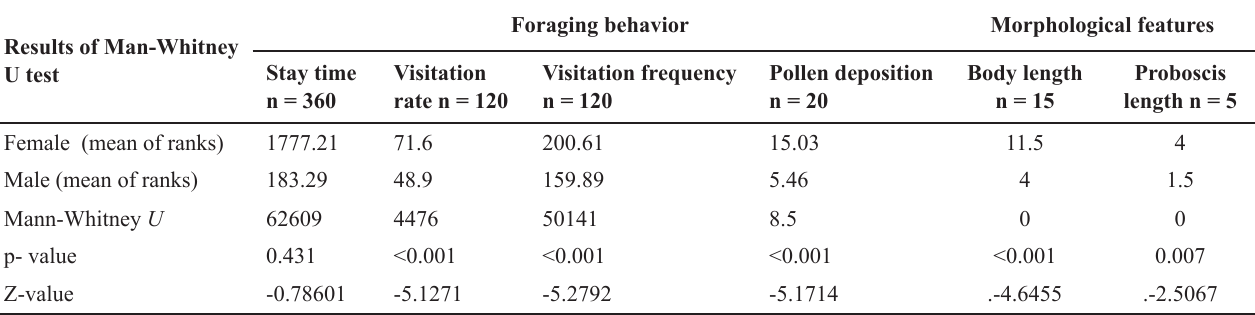
Table 2 . Comparison of foraging behavior and morphological features of female and male M. cephalotes using Man-Whitney U test at alpha 0.05 (n = number of observations ).